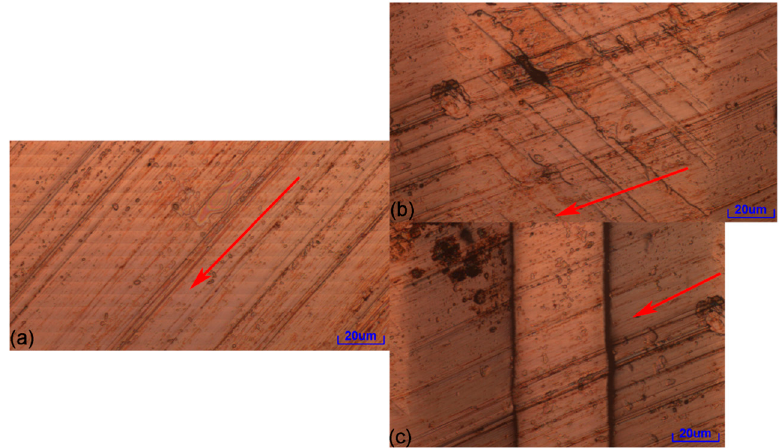
Figure 23. Local magnified surface morphology of three different regions of the microchannel that is face-to-face with the mould under the laser energy of 1800 mJ: ( a ) surface topography of the original copper foil, ( b ) surface image at bottom region, and ( c ) surface topography at the bar region. The arrows represent the rolling direction of the copper foil.